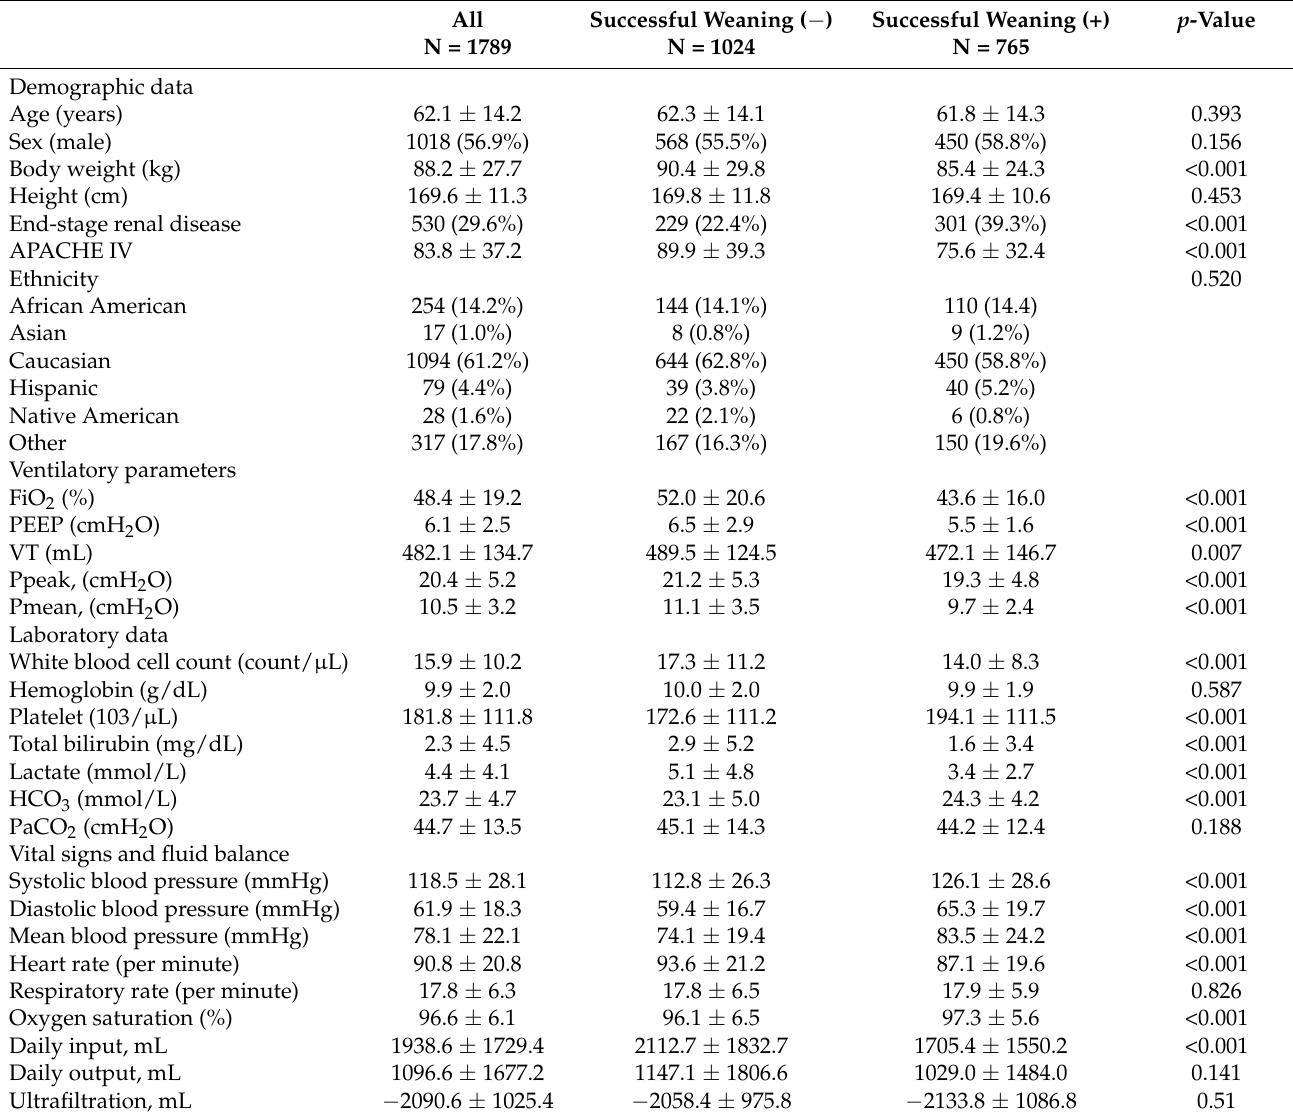
Table 1. Characteristics of the 1789 critically ill ventilated patients receiving hemodialysis, categorized by weaning